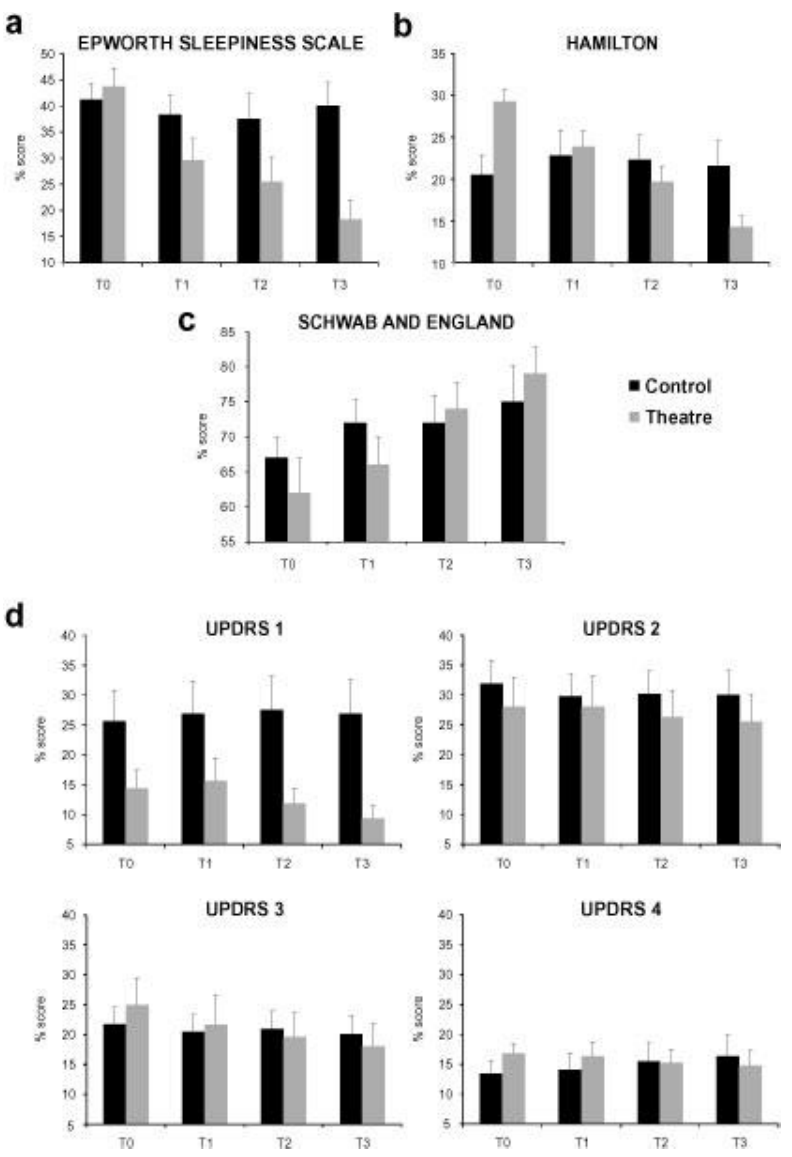
FIGURE 1. Mean scores and standard error of the means at the four time points in the Epworth Sleepiness Scale (A), Hamilton Depression Rating Scale (B), Schwab and England Scale (C), and in the four subscales of the UPDRS (D). All values are reported as percentage with respect to